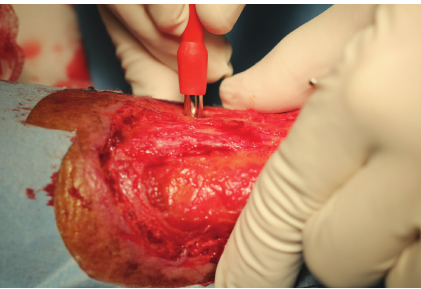
Figure 2: Holes were drilled in the ulcer using a punch 5 mm while maintaining a distance of one centimeter between the holes.